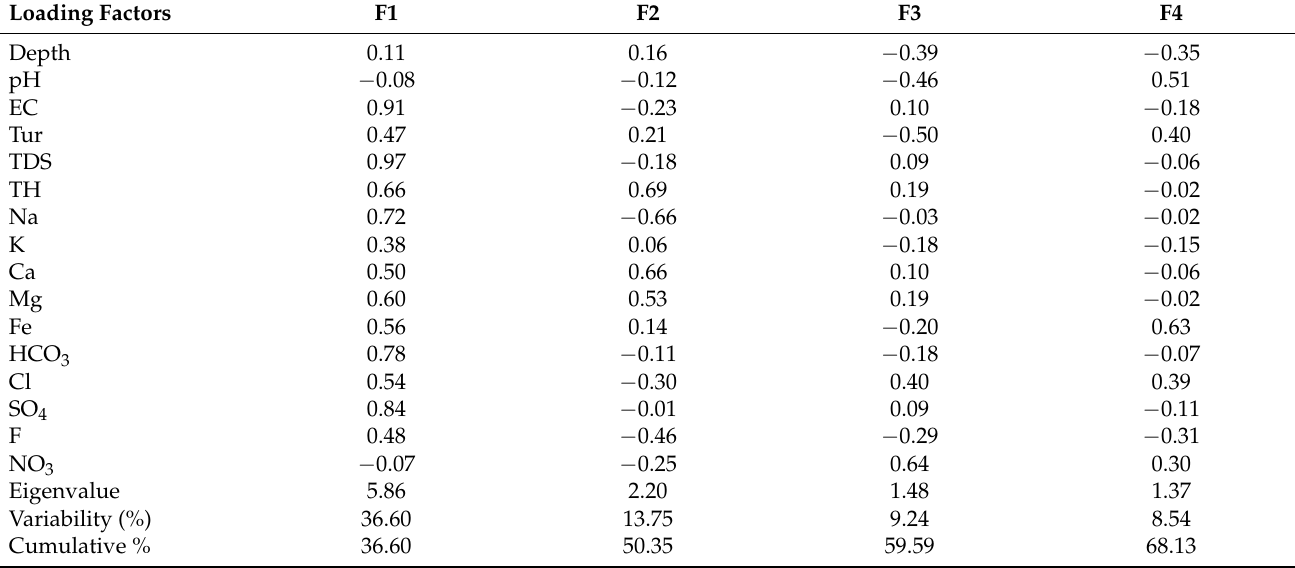
Table 3. Rotated factor loadings for the groundwater samples in the Khanewal